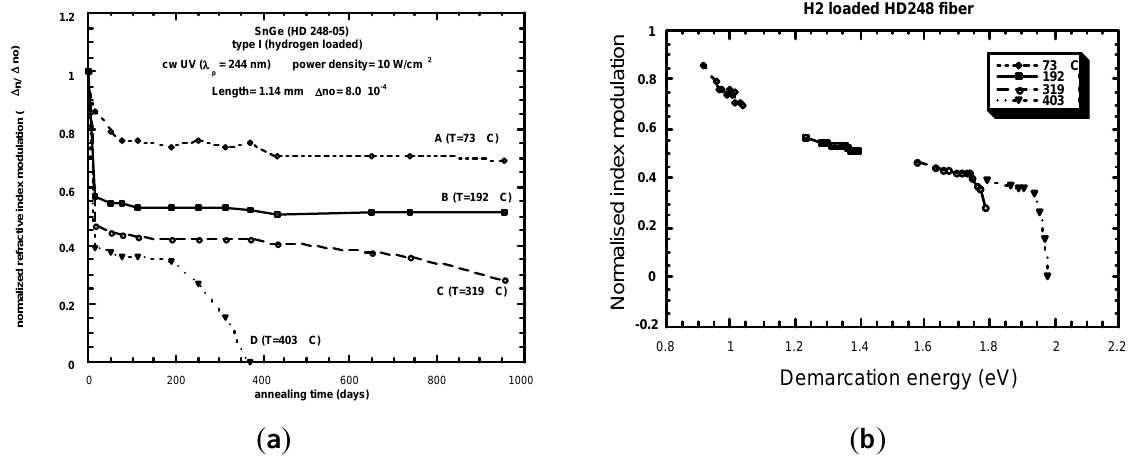
Figure 42. Results from [40], Copyright 2000 University Lille 1. The second master curve for large t and T . Theory of serial reactions. ( a ) Isothermal annealing curves; ( b ) Master curve collapsing.